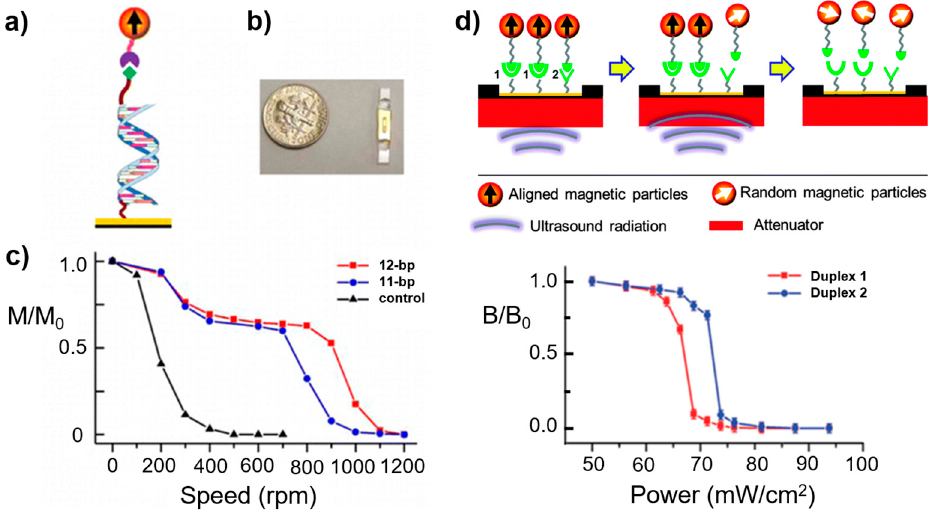
Figure 8. FIRMS studies using DNA: ( a ) a schematic of the FIRMS setup for DNA duplexes, ( b ) a photo of the sample well, ( c ) two DNA duplexes distinguished in a plot of magnetization versus force, and ( d ) the principle of acoustic radiation force (top figure) and an illustration binding profile of two DNA duplexes with the plot of magnetic field versus ultrasound power. Reproduced with permissions from [194], copyright 2014 Royal Society of Chemistry and from ref. [195], and copyright 2013 American Chemical Society.